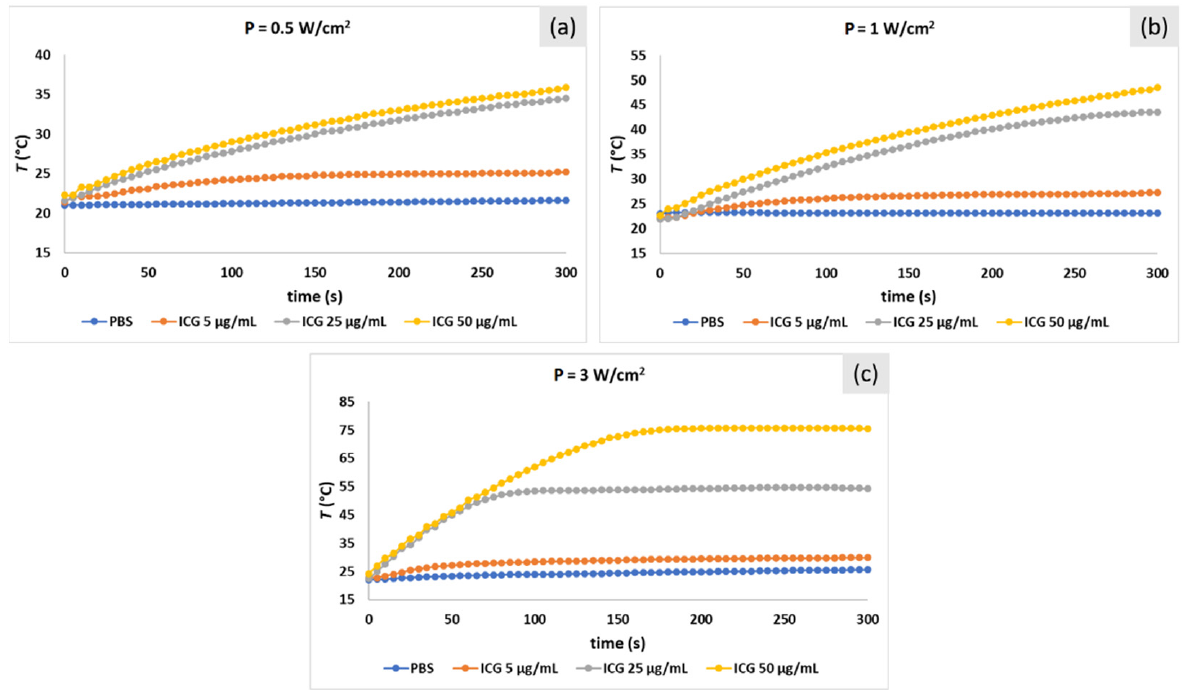
Figure 4. Temperature profiles of ICG solutions (5, 25, and 50 μ g/mL) in PBS irradiated with 808 nm laser at laser power ( a ) P = 0.5 W/cm 2 , ( b ) P = 1 W/cm 2 , and ( c ) P = 3 W/cm 2 . PBS solution was irradiated as a control.